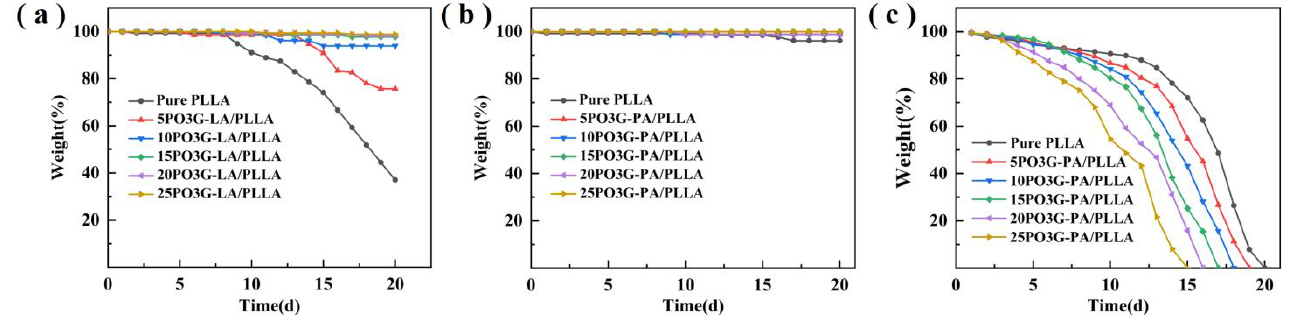
Figure 12. pH degradation curves of PO3G–PA/PLLA composite films with different ratios ( a ) pH = 3; ( b ) pH = 7; ( c ) pH = 11.